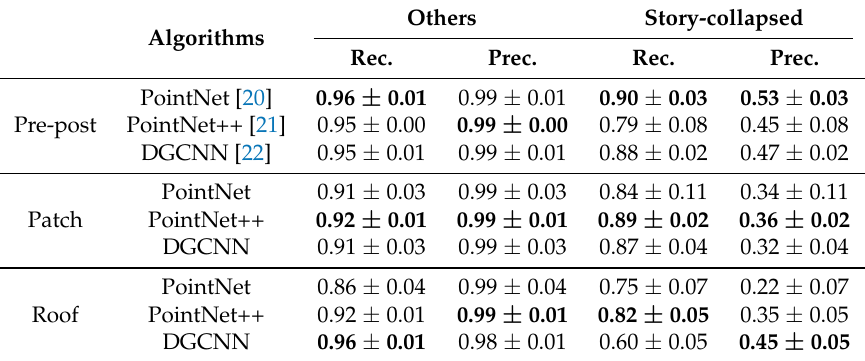
Table 7. Results of fine-grained analysis. The best performances in each category and data availability are